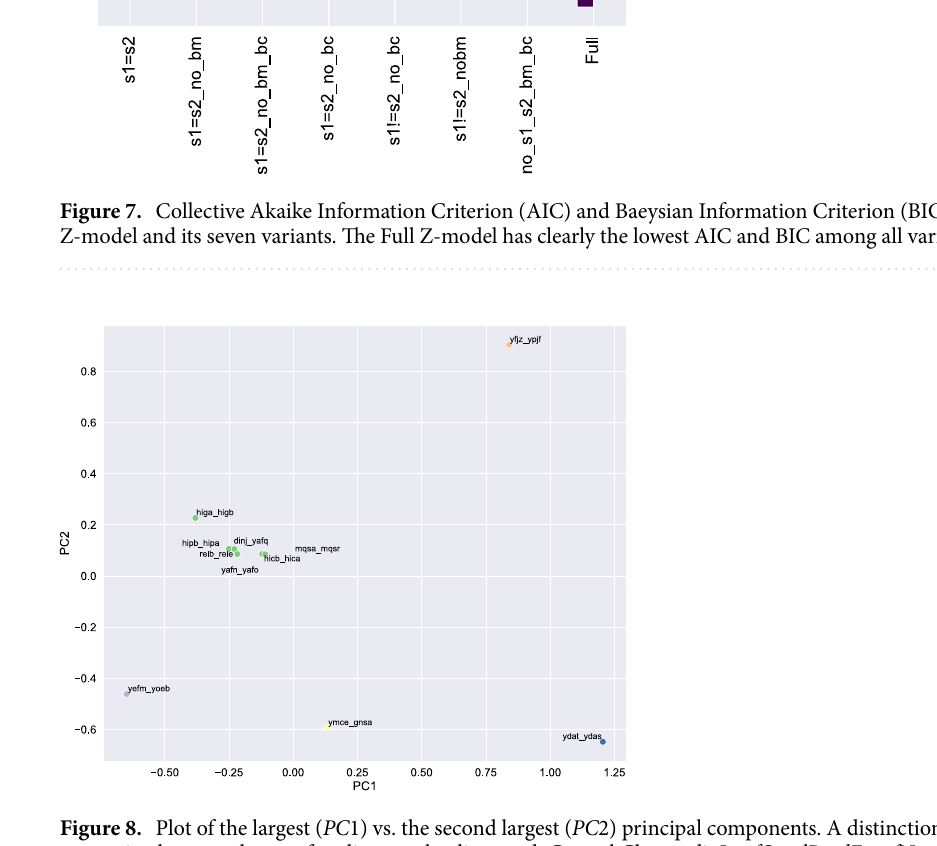
Figure 8. Plot of the largest ( PC 1) vs. the second largest ( PC 2) principal components. A distinction between one main cluster and a set of outliers can be discerned: Central Cluster dinJ - yafQ , relB - relE , yafN - yafO , higA - higB , hipB - hipA , hicB - hicA , and mqsA - mqsR . Outliers yefM - yoeB , ydaT - ydaS , ymcE - gnsA , and yfjZ - ypjF